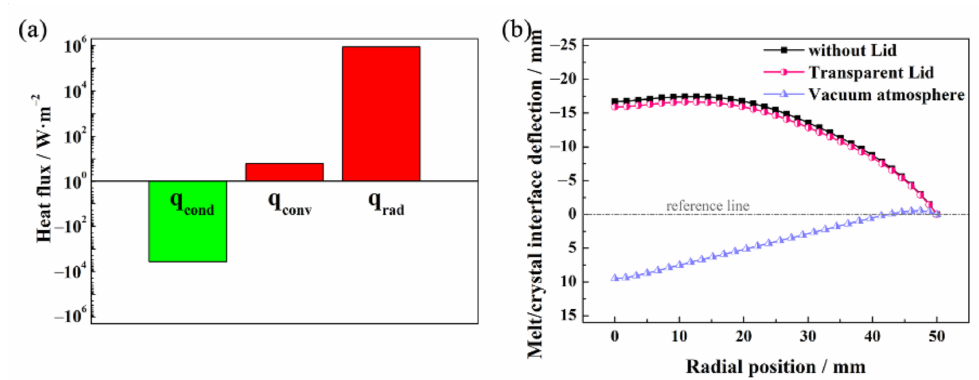
Figure 3. ( a ) Average heat flux of thermal conduction, thermal convection, and incoming thermal radiation on the undersurface of the insulation lid. ( b ) The melt/crystal interface shapes in CZ systems that without lid, with transparent lid, and within vacuum atmosphere.